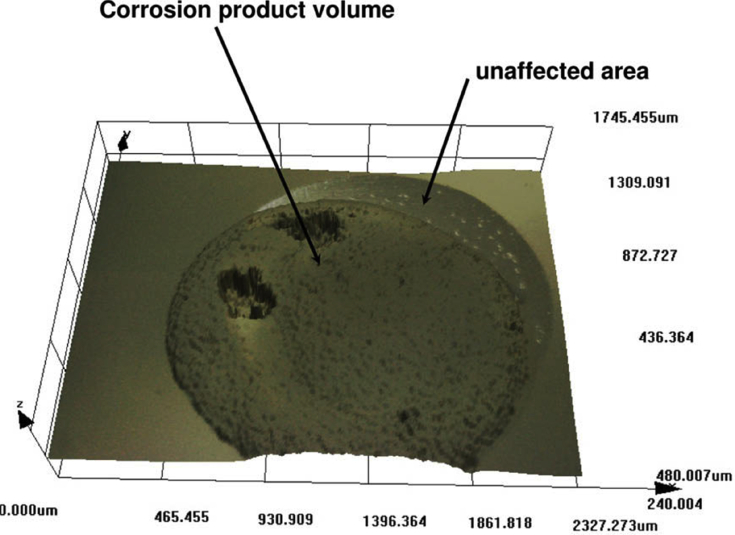
Duplex stainless steel under galvanodynamic control studied in situ, using confocal imaging. The x, y, z axes represent length in units of micrometres. From Leiva-Garcia et al. [2010].9